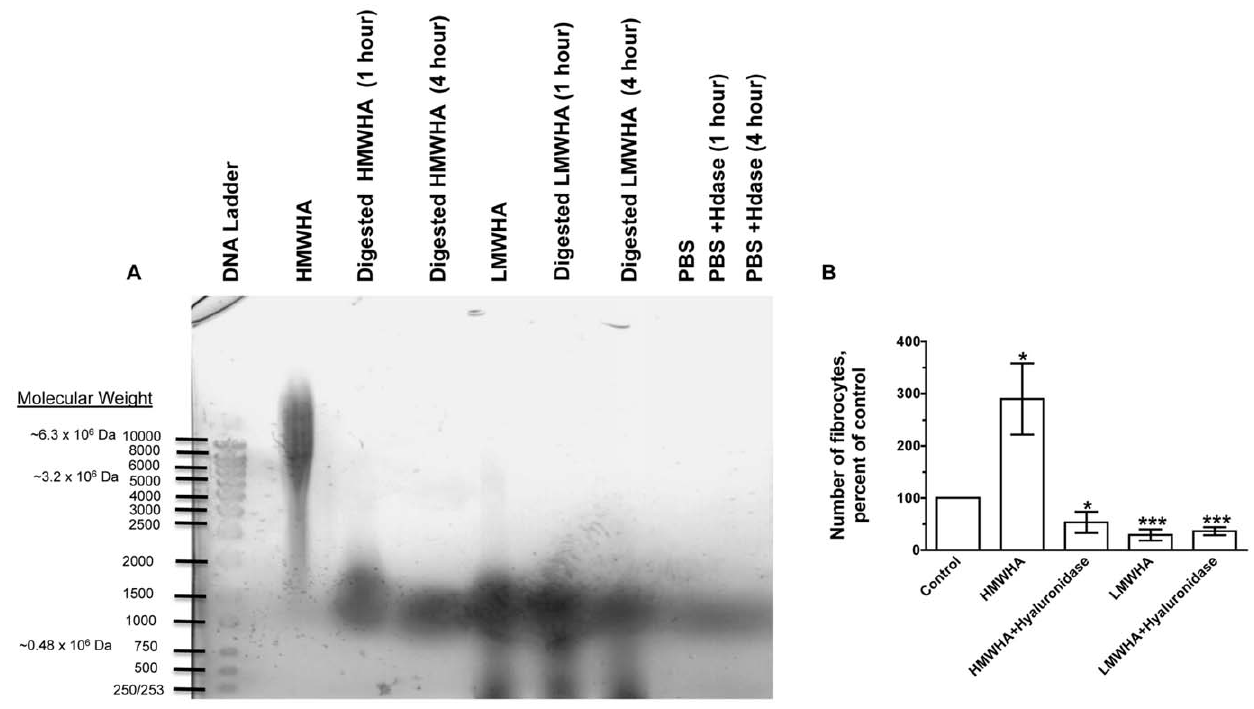
Figure 3. HMWHA and LMWHA treated with hyaluronidase inhibit fibrocyte differentiation. ( A ) HMWHA and LMWHA were treated with 10 U/ml of hyaluronidase for 1 and 4 hours at 37 u C. Samples were analyzed by agarose gel electrophoresis. M, 1 Kb ladder; Lane 1, HMWHA; Lane 2, HMWHA incubated with hyaluronidase for 1 hour; Lane 3, HMWHA incubated with hyaluronidase for 4 hours; Lane 4, LMWHA; Lane 5, LMWHA incubated with hyaluronidase for 1 hour; Lane 6, LMWHA incubated with hyaluronidase for 4 hours; Lane 7, PBS; Lane 8, PBS incubated with hyaluronidase for 1 hour; and Lane 9, PBS incubated with hyaluronidase for 4 hours. ( B ) Human PBMC were cultured in 300 m g/ml of 4 hours- hyaluronidase-treated or untreated HMWHA and LMWHA. After 5 days, the cells were air dried, fixed, stained, and the number of fibrocytes was counted. The results are mean 6 SEM of SFM percent control (n=6 separate experiments). The number of fibrocytes in SFM controls from the 6 donors was 883, 1029, 808, 288, 400, and 288. * indicates p , 0.05, ** p , 0.01, *** p , 0.001 as determined by t-test. Using the non-parametric Mann Whitney two-tailed t-test, 300 m g/ml HMWHA significantly increases the number of fibrocytes when compared to control with p , 0.001, but 300 m g/ ml hyaluronidase incubated HMWHA is not significantly different from control. Also, 300 m g/ml LMWHA significantly decreases the number of fibrocytes when compared to control with p , 0.001, and 300 m g/ml hyaluronidase incubated LMWHA also significantly decreases the number of fibrocytes when compared to control with p , 0.001. Using the non-parametric Mann Whitney one-tailed t-test, 300 m g/ml hyaluronidase incubated HMWHA significantly decreases the number of fibrocytes when compared to control with p , 0.05.